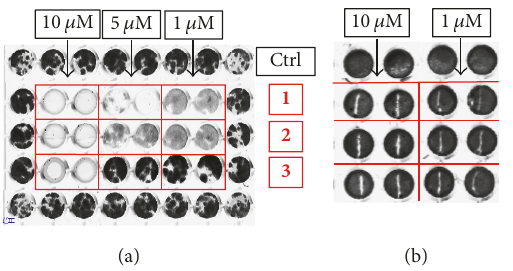
Figure 7: Inhibition of colony formation (a) and migration (b) of OVAR-8